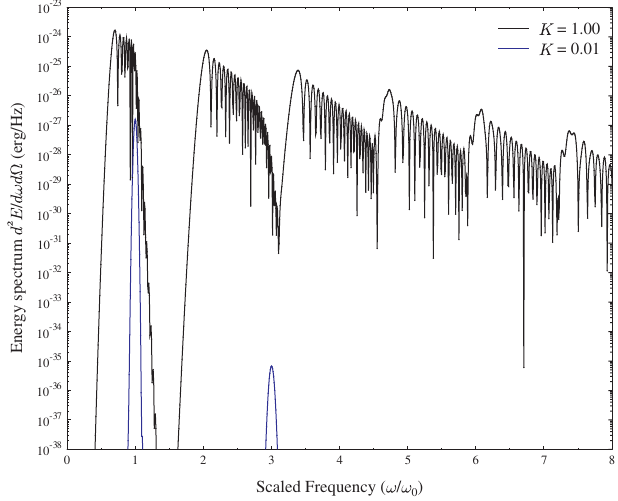
FIG. 4. (Color) Forward energy spectrum for Gaussian ampli- tude modulated